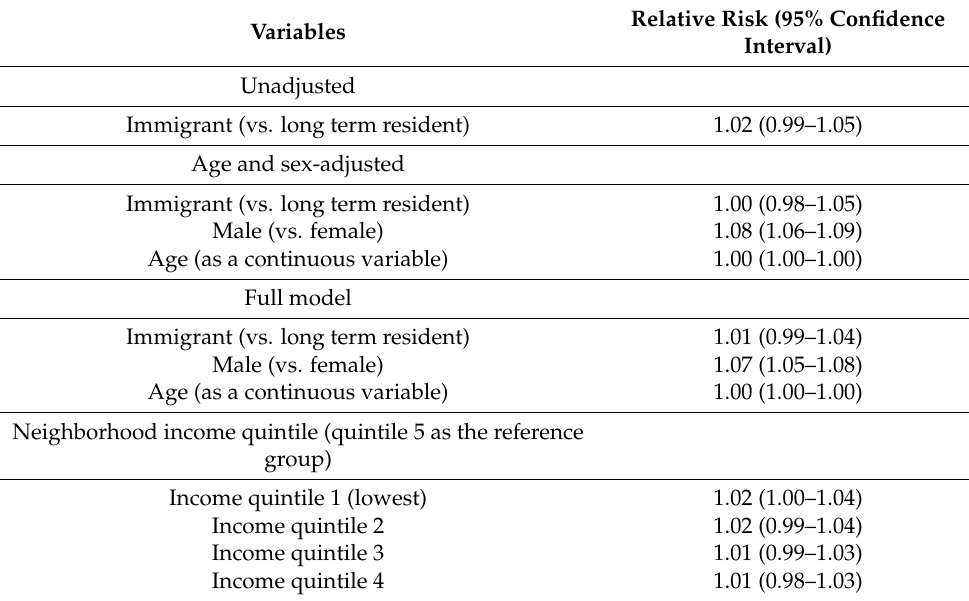
Table 3. Results from the multivariable model using Poisson regression. Adjusted relative risks represent late vs. early stage of